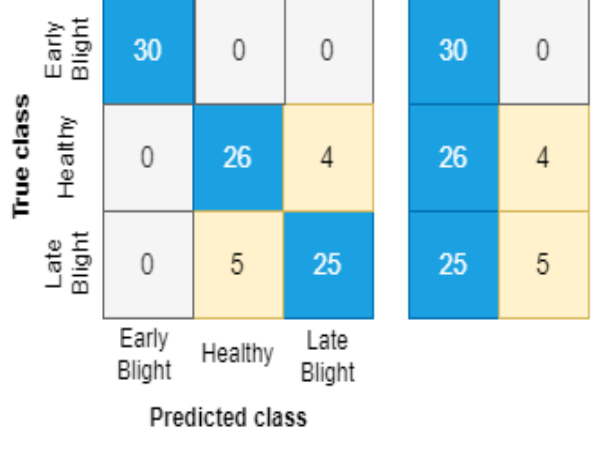
Execution Performance comparison with existing work Author Proposed algorithm software